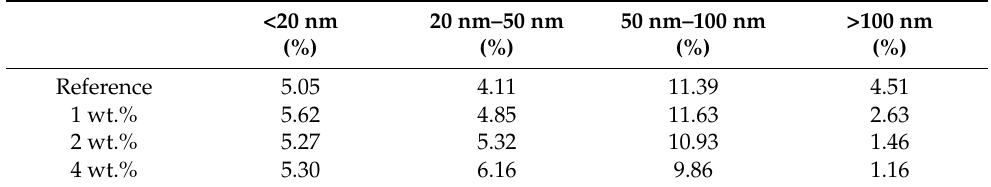
Table 8. The pore volume at different pore size ranges for cement paste in the presence of hydro- phobic functional corrosion inhibitor with different concentrations at 28 d of curing.